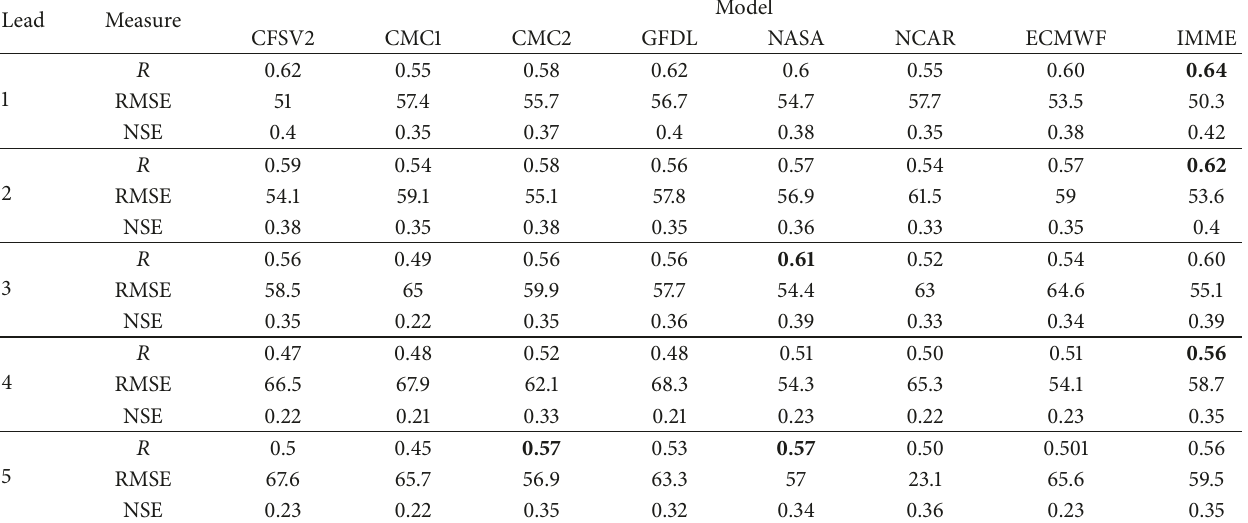
Table 3: Correlation, RMSE, and NSE for observed monthly precipitation versus the models predictions: one to five months’ lead times, Central Israel, Latitude: 32.0, Longitude: